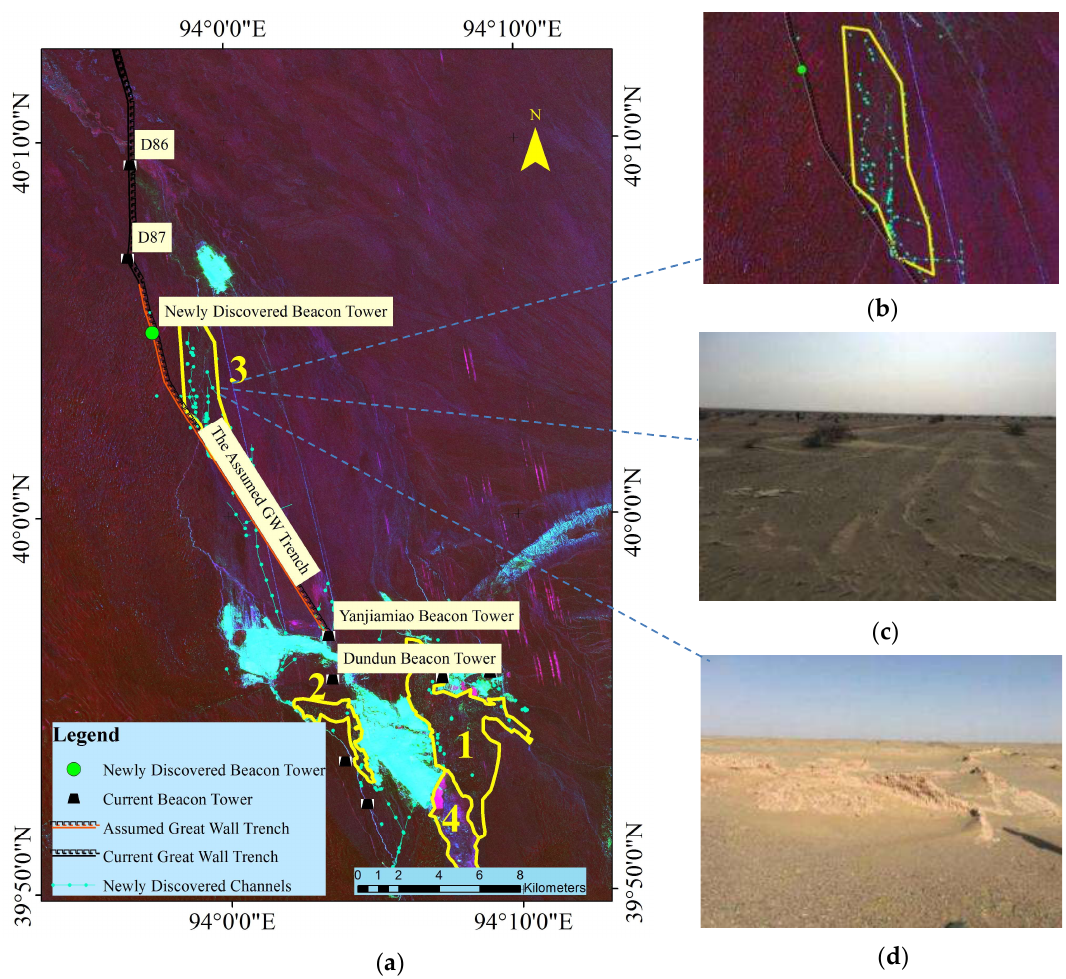
Figure 14. ( a ) The location of target 3 with the assumed Great Wall trench and beacon towers overlaid on the composite results; ( b ) the location of target 3 and the abandoned channels, ridges, and a newly discovered beacon tower; ( c ) field photos of the abandoned channels and ridges; ( d ) a farmhouse located in area 3.